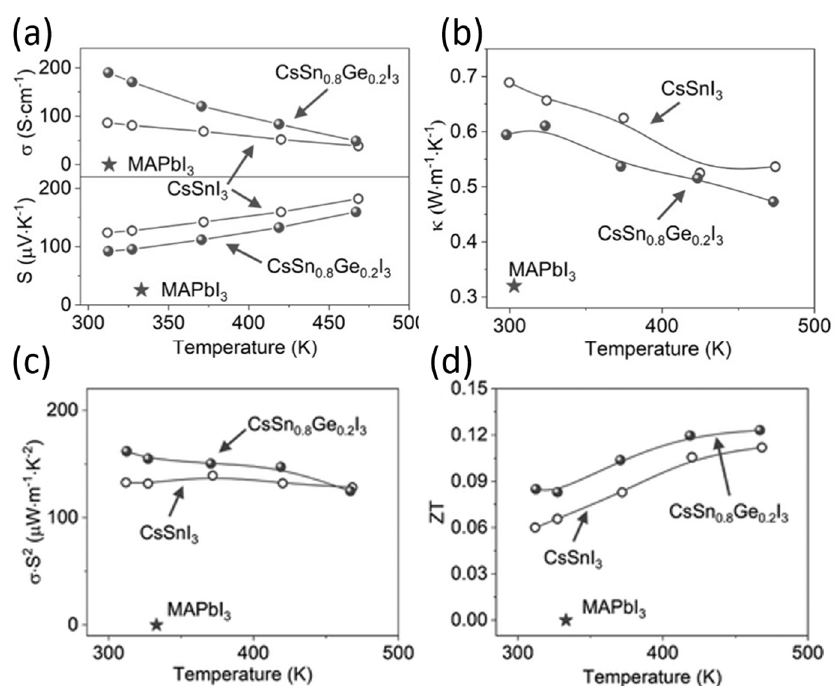
Figure 30. ( a ) The measurement of electrical conductivity and Seebeck coefficient under variable temperature, ( b ) The measurement of thermal conductivity under variable temperature, ( c ) Calculated power factor under variable temperature, ( d ) Calculated figure of merit under variable temperature. Reproduced with permission [144]. Copyright 2020, American Chemical Society.